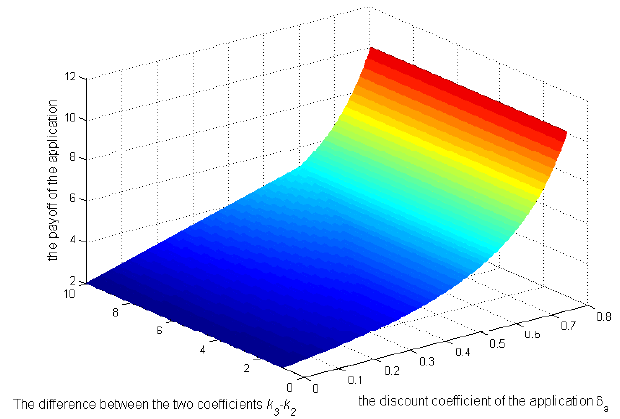
Figure 7. Impact of k 3 − k 2 and δ a on the application’s strategies.